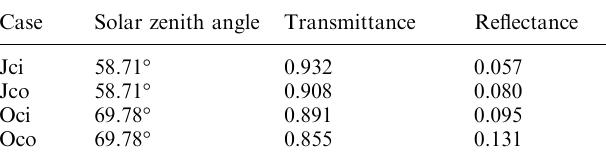
Table 3. Solar radiative properties of cirrus and contrails as derived from RTM calculations. (Jci: July, cirrus, Jco: July, contrails, Oci: October, cirrus, Oco: October, contrails)